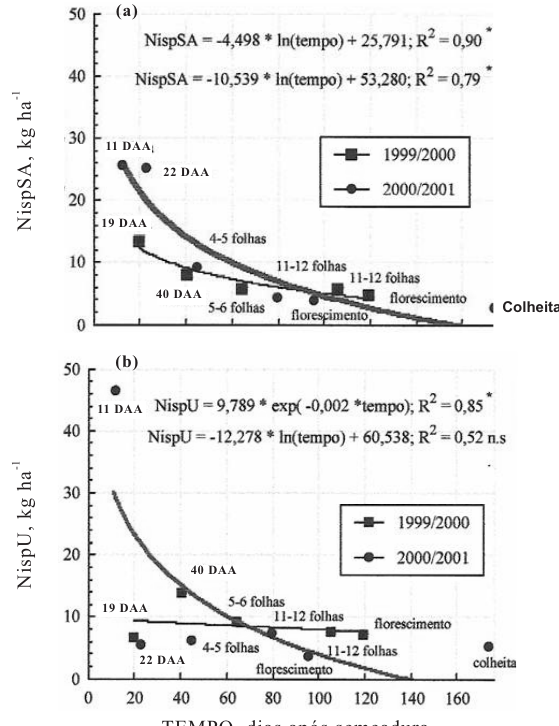
Figura 2. Nitrogênio imobilizado no solo de sulfato de amônio ( NispSA ) (a) e da uréia ( NispU ) (b), aplicado em pré-semeadura na entrelinha das futuras fileiras de plantas de milho, em duas safras consecutivas (1999–2001), em sistema plantio direto. (DAA = dias após